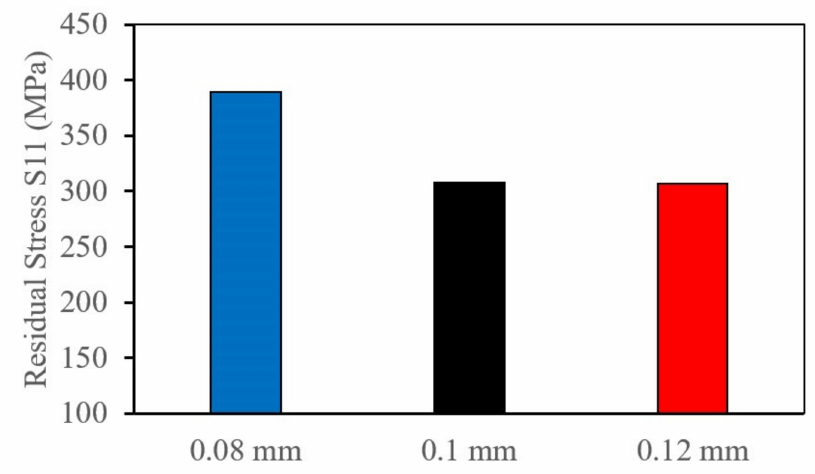
Figure 31. Effect of hatch spacing on surface